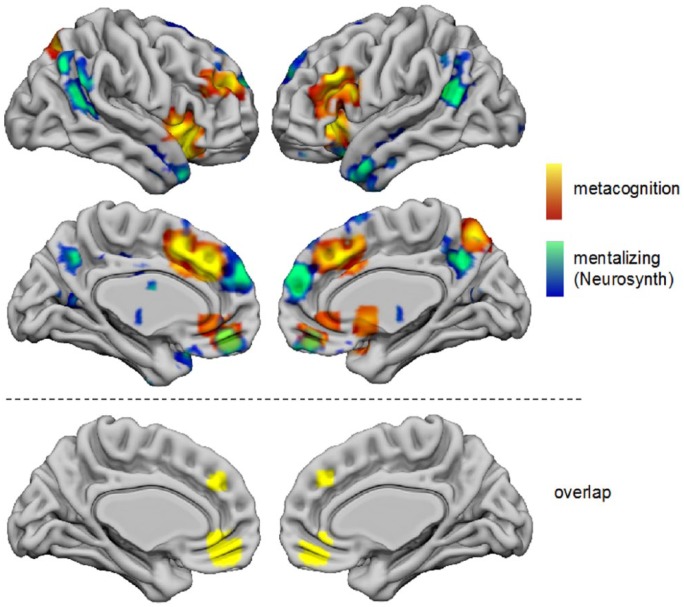
ALE results for all studies on metacognition (from Figure 1, hot colours) as
compared to the Neurosynth reverse inference map for the term
‘mentalising’ (cool colours). Clusters are displayed in a 3D rendering
of MNI standard space.